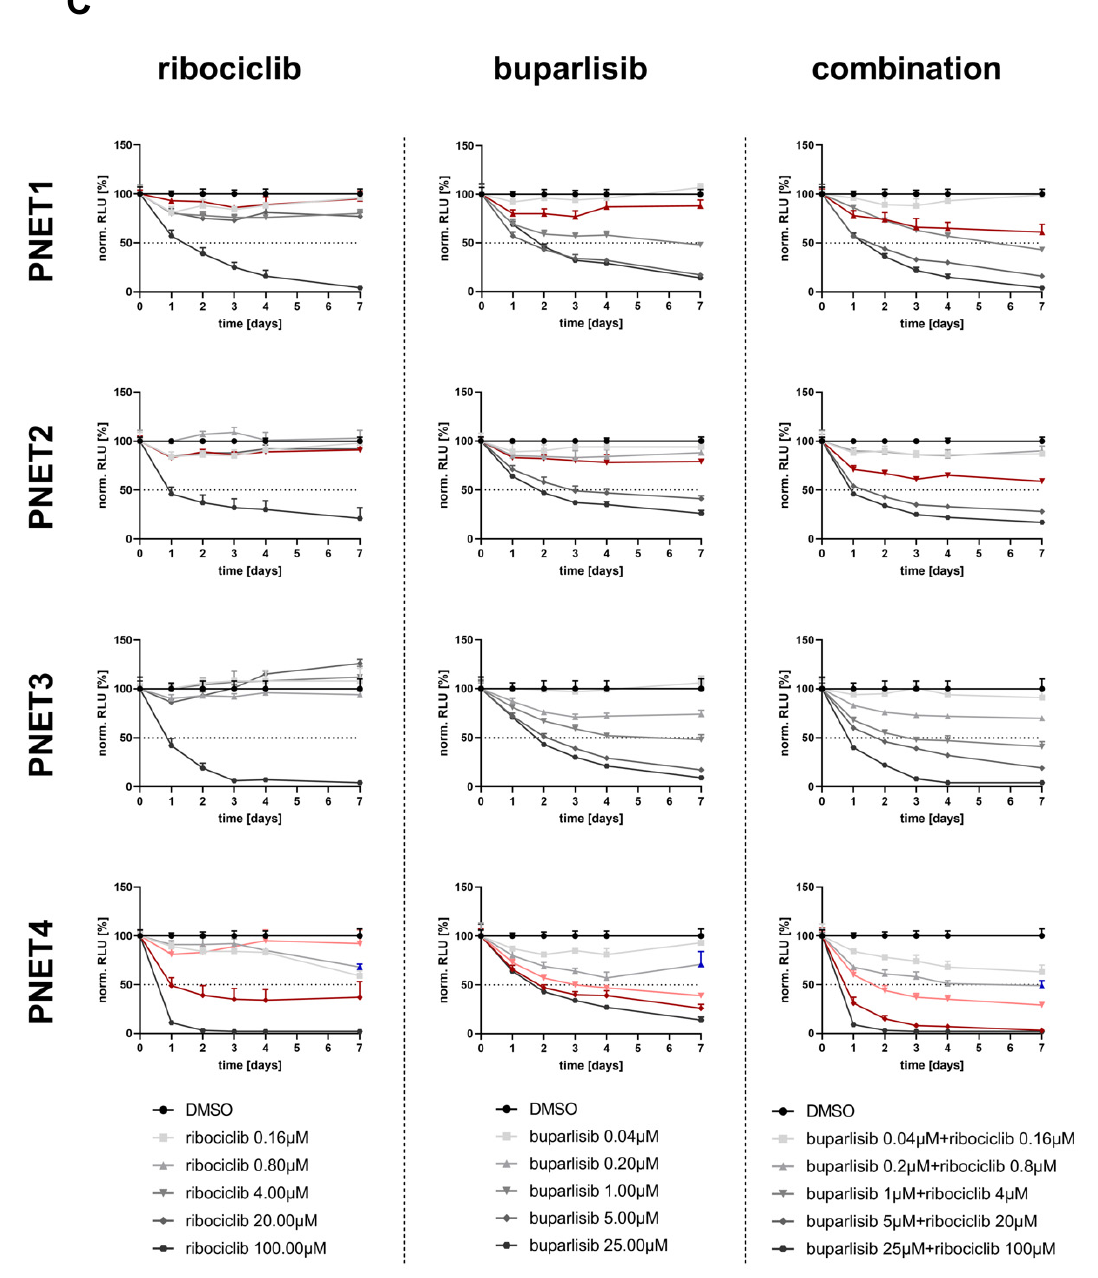
Figure 8. Effect of buparlisib and ribociclib on cell viability of primary human 3D tumoroids. ( A,B ) Representative images of sample PNET4. ( A ) H&E staining (H&E) of the original tumor tissue. Scale bar (250 μ m). ( B ) H&E staining and staining for synaptophysin of micro ‐ cell ‐ block samples from the day of isolation (Day 0) and DMSO ‐ treated samples 12 days post ‐ isolation (Day 12). MCB = Micro ‐ cell ‐ block; SYN = Synaptophysin. Scale bar MCB Day 0 (100 μ m), scale bar inset (20 μ m), scale bar MCB Day 12 (50 μ m). ( C ) Cell viability curves of human tumoroids PNET1, PNET2, PNET3 and PNET4 treated with different concentrations of buparlisib, ribociclib and their combination for 7 days. For clarity, each single treatment and the combination are shown separately. Drug concentra ‐ tions are reported below the graphs. Drug concentrations for which the combination was more ef ‐ fective than the individual drugs are illustrated in red. Data were first normalized per ‐ well using a